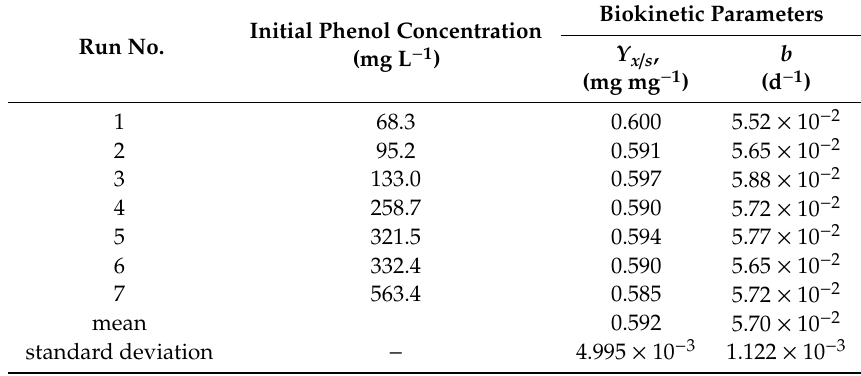
Table 3. Determination of growth yield and decay coe ffi cient of P. putida cells.